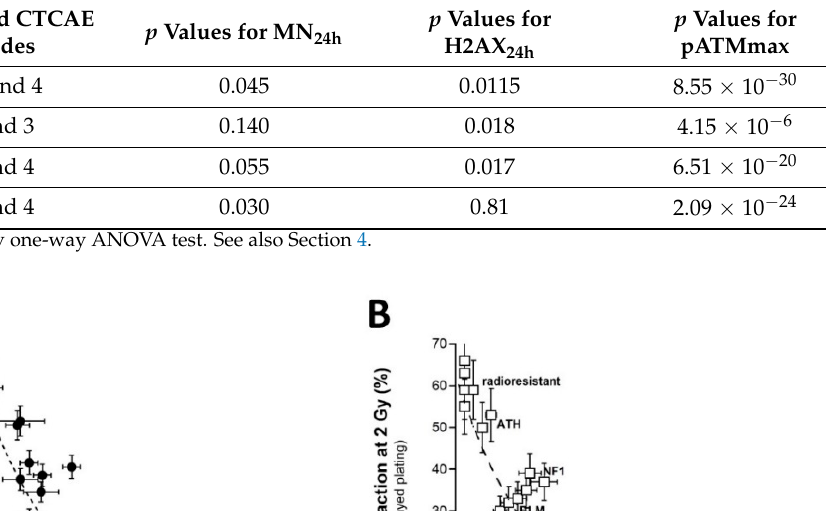
Figure 2. Micronuclei vs. CTCAE grades. The number of spontaneous micronuclei per 100 cells ( A ) or micronuclei assessed 24 h post-irradiation per 100 cells ( B ) from 200 COPERNIC cell lines were plotted against the corresponding CTCAE grade values (closed circles). Each point corresponds to the mean ± standard error of the mean (SEM) of three independent triplicates, at least. The points corresponding to the ATM - (open circles) and the LIG4 - (open triangles) mutated cell lines are indicated. Table 2. Discrimination power of the major molecular radiosensitivity endpoints *. Compared CTCAE